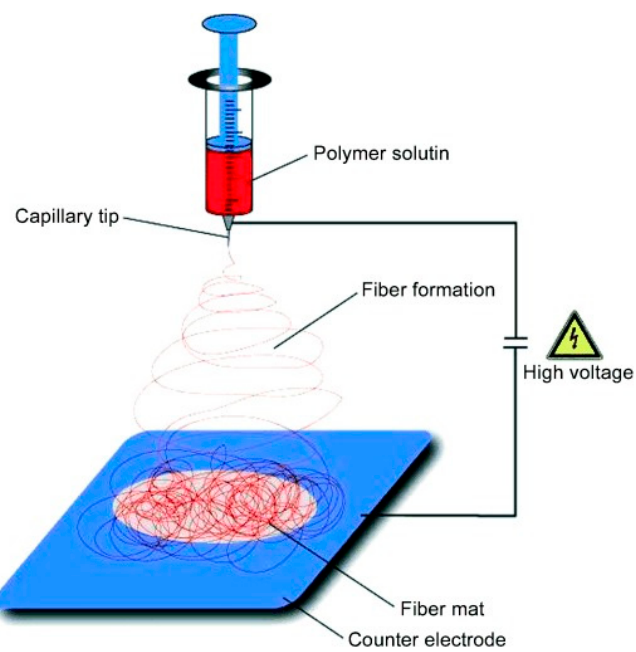
Figure 26. Illustration of the electrospinning process. Reproduced with permission from Greiner et al. [394]. Copyright (2007), John Wiley and Sons.